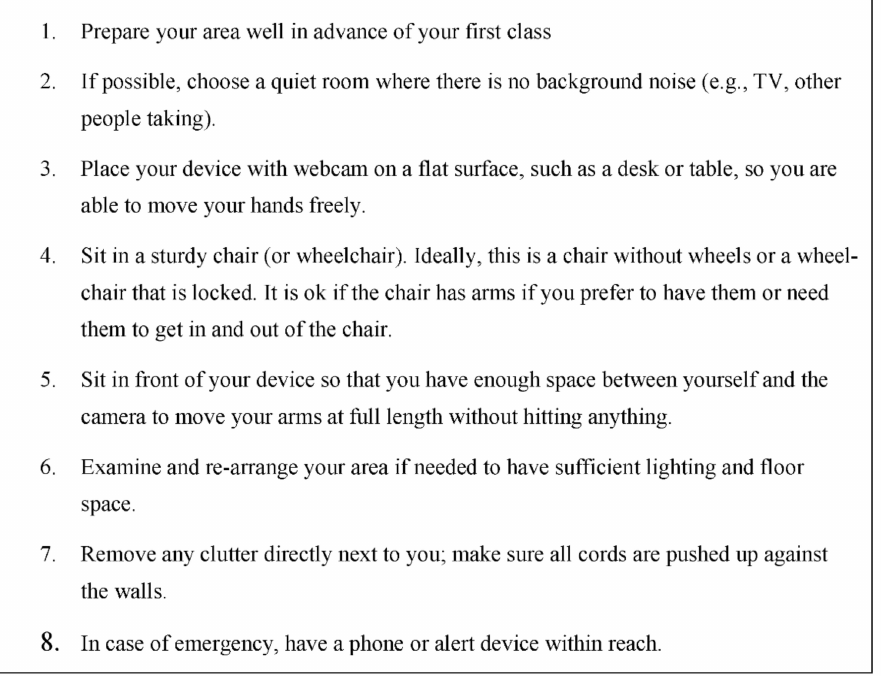
Figure 3. Environmental Setup Recommendations for Participants in Seated Telewellness Exercise